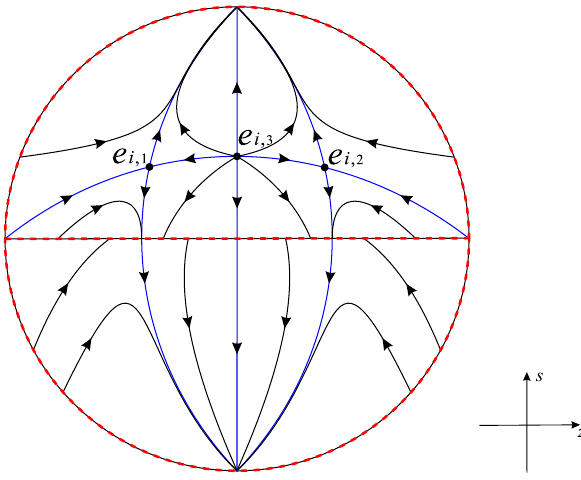
Fig. 4 The phase portrait of system (7) at infinity on local chart U 1